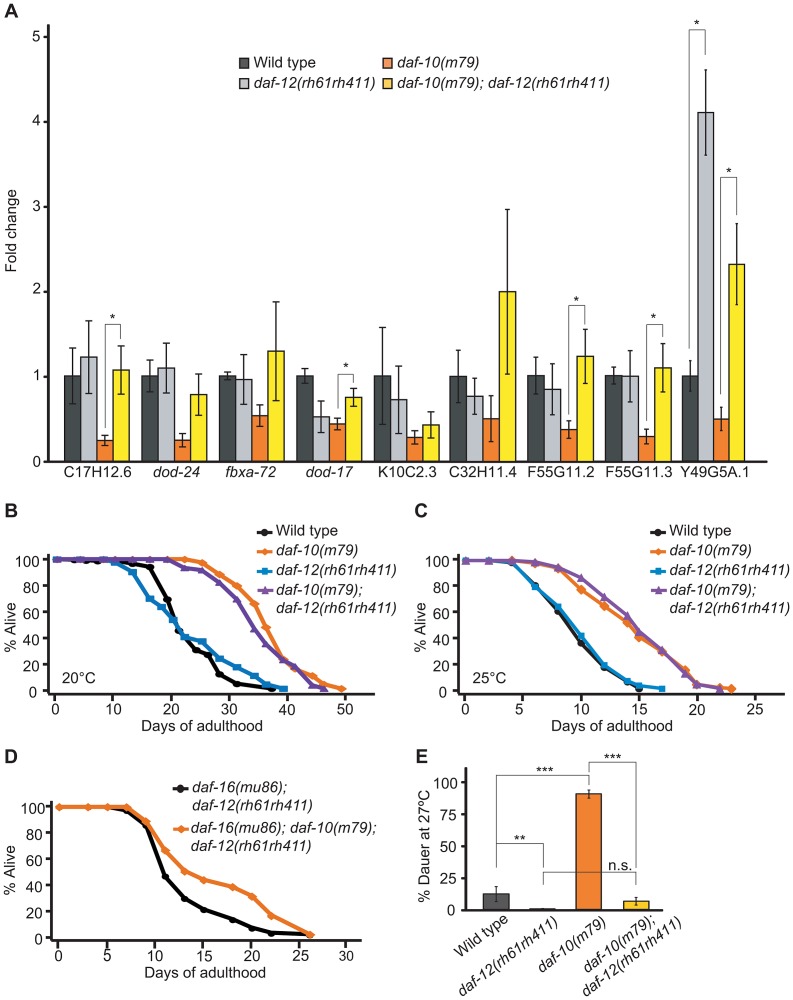

daf-10 mutations influence the expression of DAF-12/NHR-regulated genes.A. qRT-PCR was used to determine whether the putative DAF-12 targets were regulated in a daf-12/NHR-dependent fashion in the daf-10(m79) background. B–C. daf-12/NHR was not required for daf-10(m79) mutant animals to live long at 20°C (B) or at 25°C (C). D. Mutations in daf-10 can still extend the lifespan of daf-16(mu86); daf-12(rh61rh411) mutant animals. A summary of the data presented in these panels and additional repeats is included in Table S1A. E. daf-12/NHR was required for daf-10(m79) mutants to arrest at the dauer stage when grown at 27°C. Note that the difference between daf-10(m79); daf-12(rh61rh411) and daf-12(rh61rh411) animals was not statistically significant (p = 0.07, n.s.). Error bars represent s.e.m. (* p<0.05, ** p<0.01, *** p<0.001, Student's t-test).